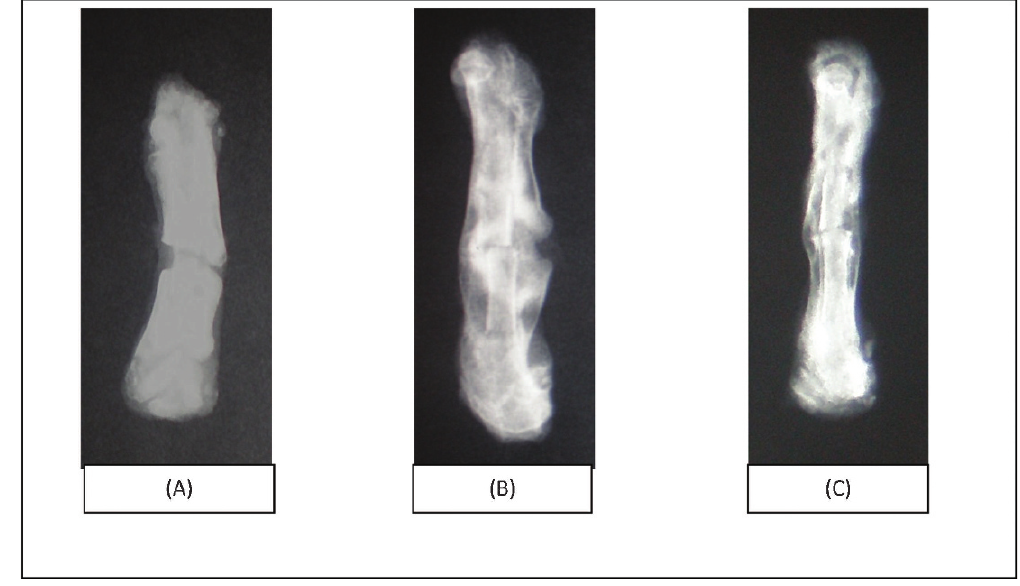
Figure 2 - X-ray images of a healed fractured femur from each group. (A) SO group; (B) OVXC group; (C) ATF